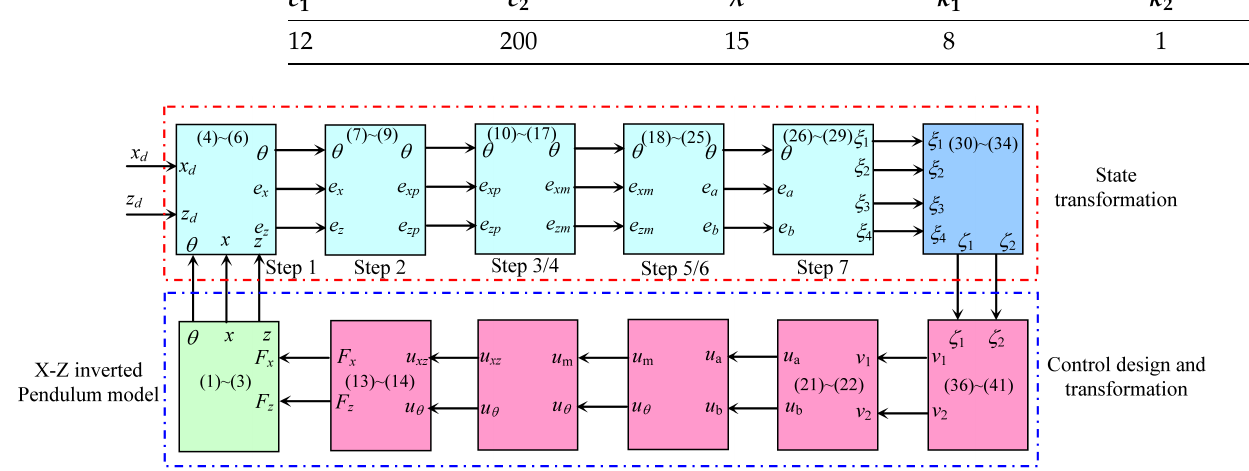
Figure 4. The control structure of the X-Z